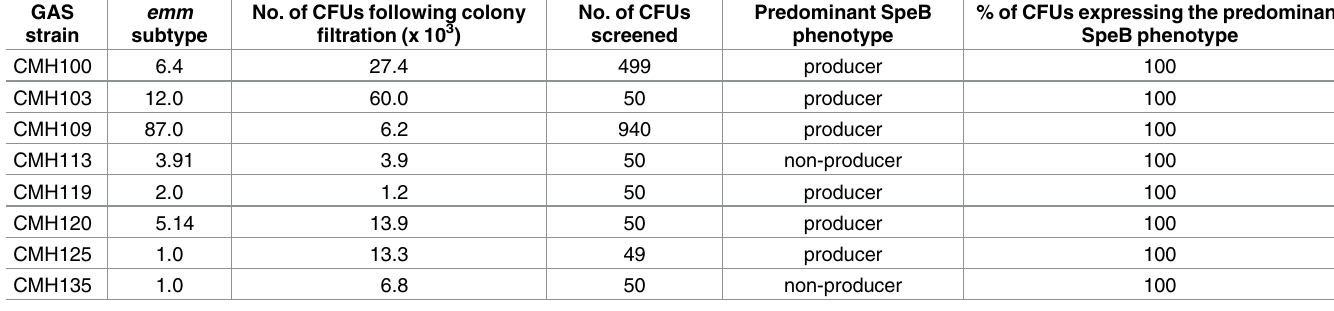
Table 4. Phenotypic homogeneity among organisms within single colonies from oropharyngeal swabs taken from pediatric patients with